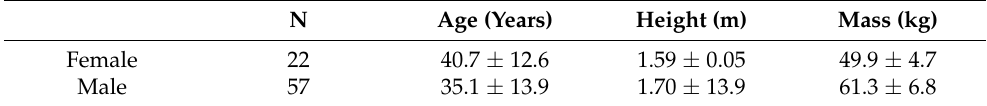
Table 1. Characteristics of subjects participating in this